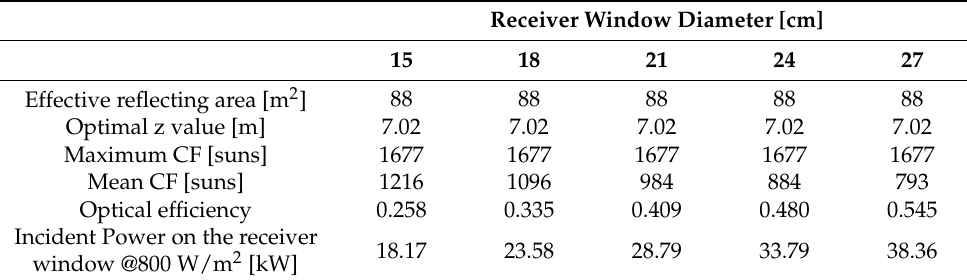
Figure 3. Results of the dish reflectance measurement [19]. Table 2. Calculated OMSoP dish